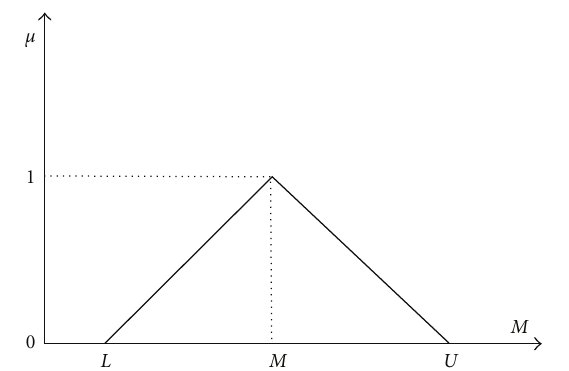
Figure 2: Hierarchical framework of research model based on BSC.